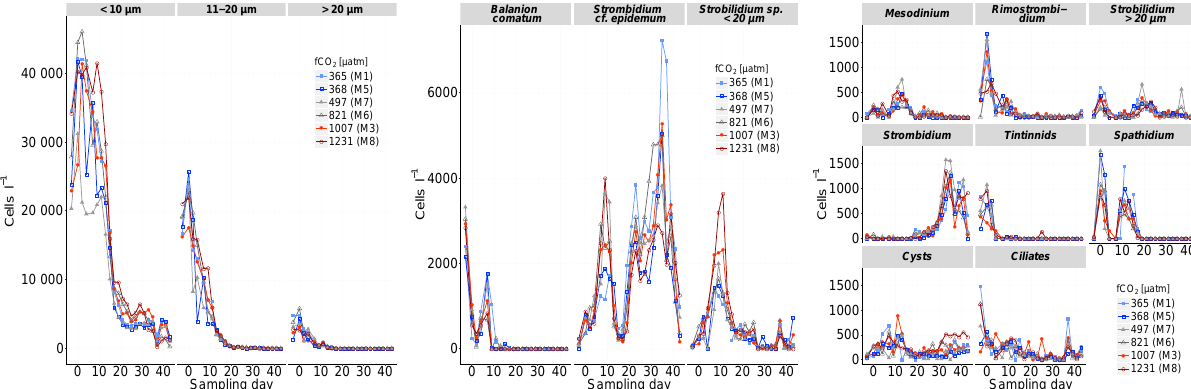
Figure 2. Left: abundance of different size classes of Myrionecta rubra . Middle–right: abundance of other ciliate species–genera–groups. Note that there is one missing value in M1 on t 13 .